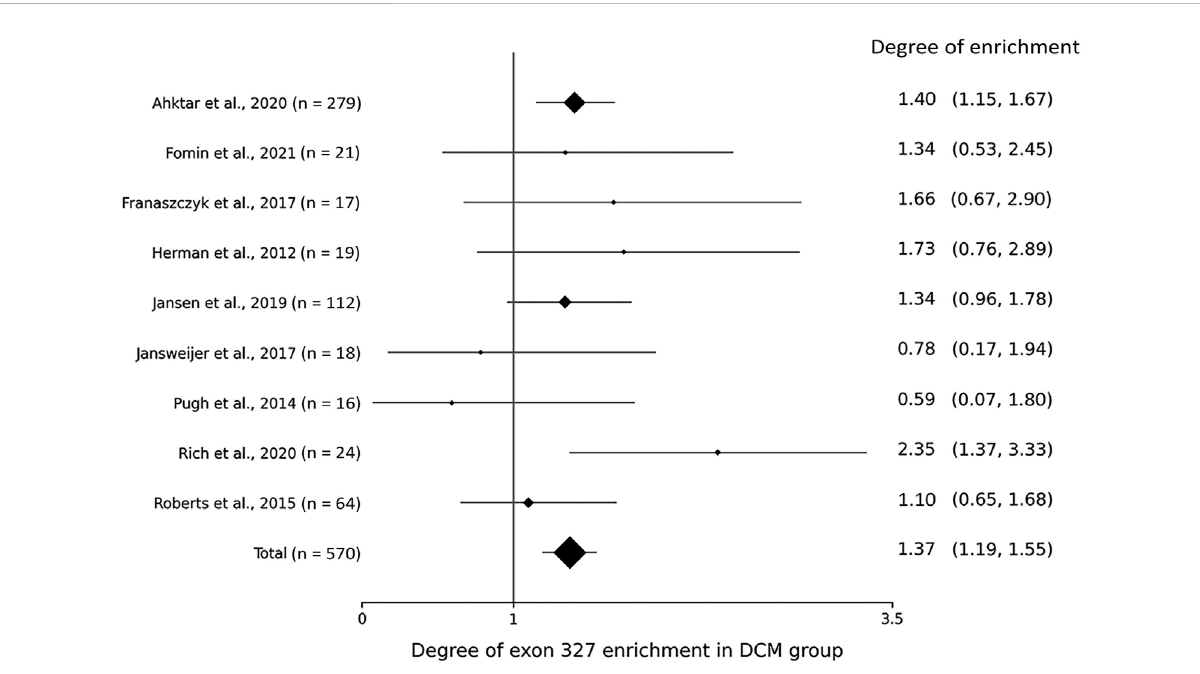
FIGURE 2 Forest plot showing the degree of titin-truncating variant (TTNtv) enrichment in exon 327 from individual